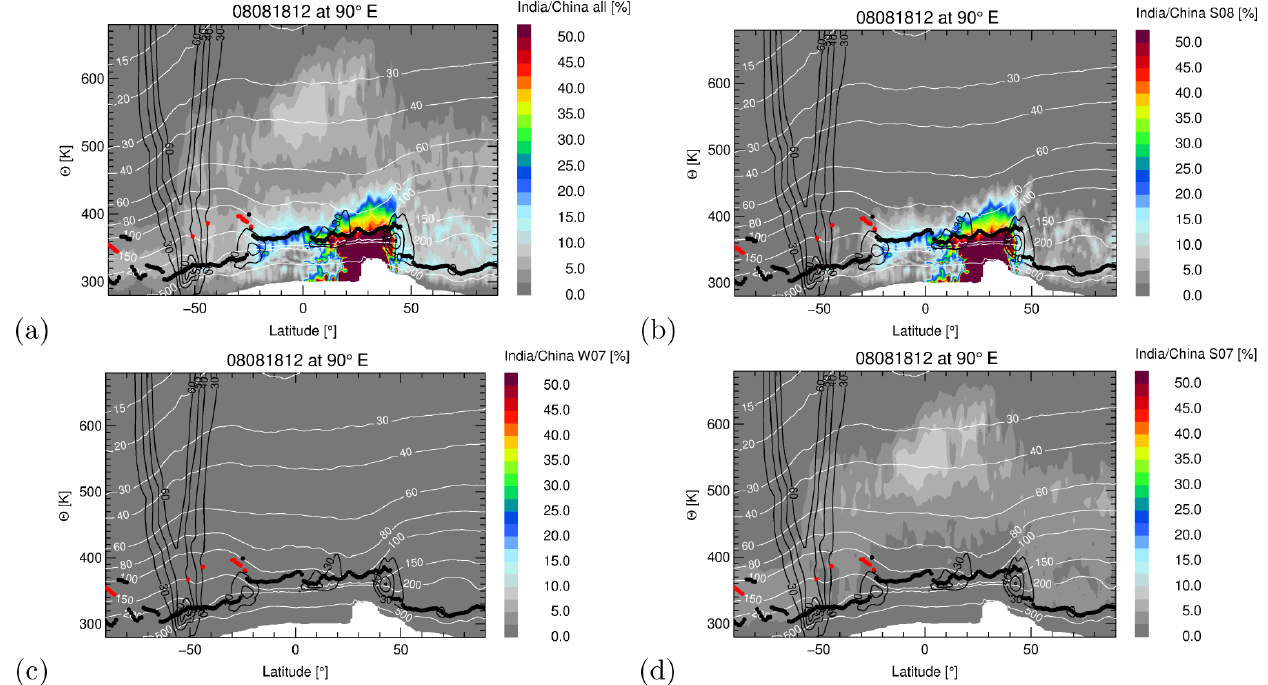
Figure 9. Latitude–theta cross sections at 90 ◦ E for the fraction of the India/China tracer for the simulation period (1 May 2007–18 Au- gust 2008 labelled as “all”) (a) , for the summer 2008 (S08) pulse (b) , for the winter 2007–2008 (W07) pulse (c) , and for the summer 2007 (S07) pulse (d) on 18 August 2008. The thermal tropopause (primary in black dots and secondary in red dots) and absolute horizontal winds (black lines for 30, 40, 50, and 60ms − 1 ) are shown. The levels of pressure are marked by thin white lines. Note that the maximum value for the winter 2007–2008 (W07) pulse (c) is